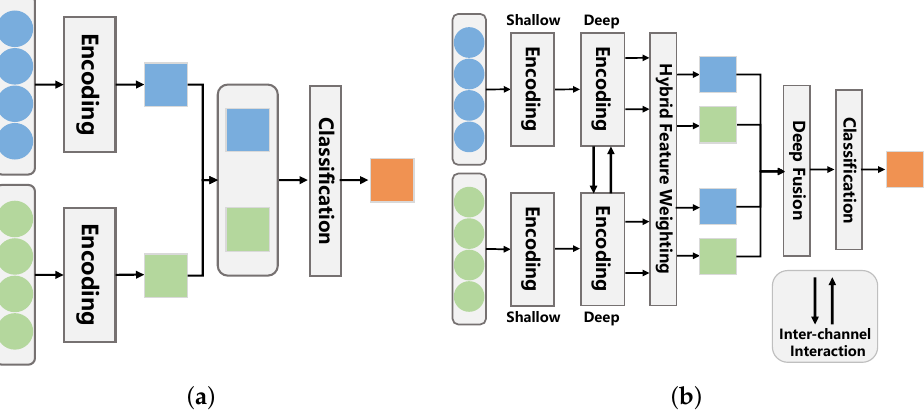
Figure 3. Intuition of CAHFW-Net: For images as in ( a , b ), conventional CAER methods that fuse the features using single-level simple concatenation only as in ( a ) often fail to overcome emotion confusion. Unlike these methods, CAHFW-Net introduces inter-channel interaction to capture complementary information between face and context as in ( b